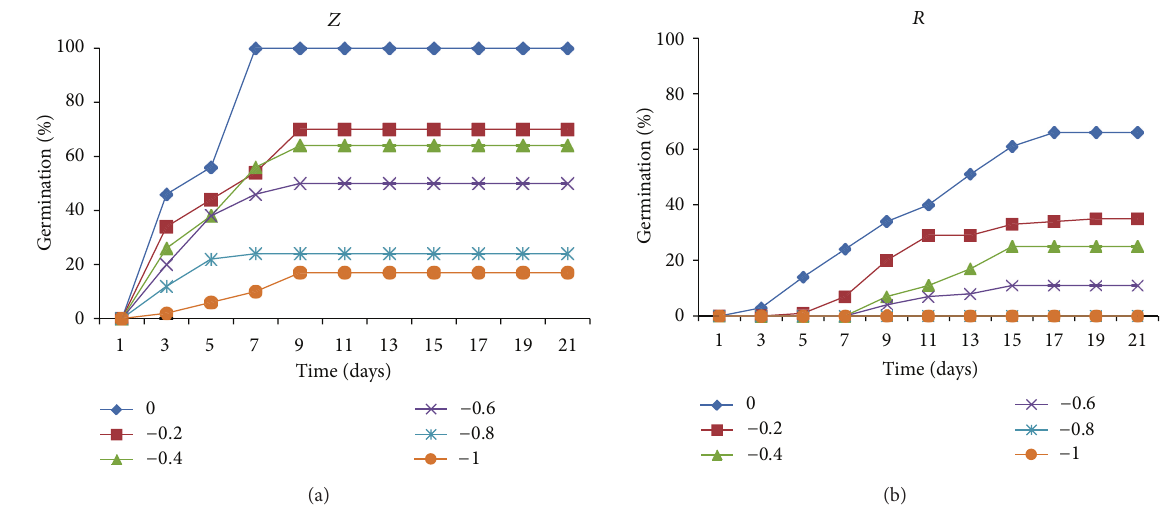
Figure 2: Cumulative germination percentage of Ziziphus lotus ( 𝑍 ) and Rhus tripartitum ( 𝑅 ) seeds at different PEG 6000 solutions of different osmotic potentials (0 to − 1MPa) ( 𝑛 = 5